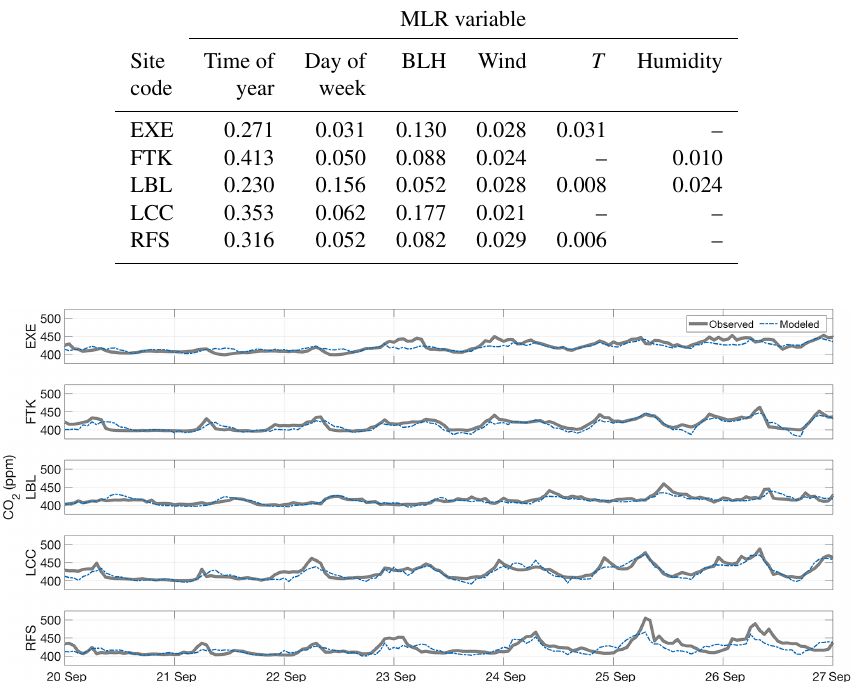
Figure 7. Representative week of total CO 2 concentrations observed (thick gray curve) and modeled (dashed blue curve) at five sites using a multiple-linear-regression approach based on de Foy